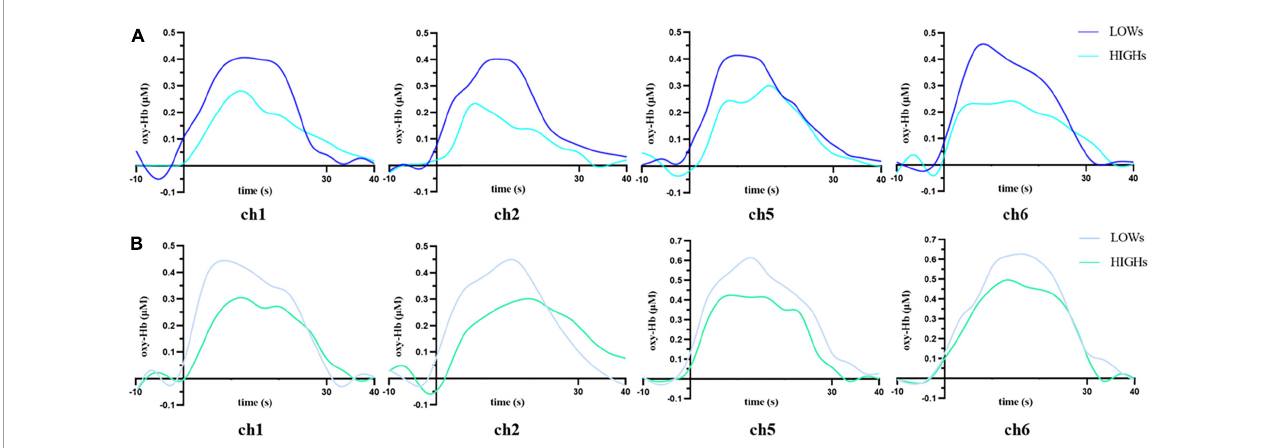
FIGURE5 Time courses for concentrations of oxygenated hemoglobin (Oxy-Hb) in the prefrontal cortex of LOWs and HIGHs during the 1-back (A) and 2-back (B) tasks. The hemodynamic response of LOWs to n-back stimulation is higher than that of HIGHs. Stimulus block starts at 0 s and lasted for 30 s. − 10 s to 0 s is baseline, and 30–40 s is post stimulus. ch, channel; LOWs, the low rMSSD group; HIGHs, the high rMSSD group.